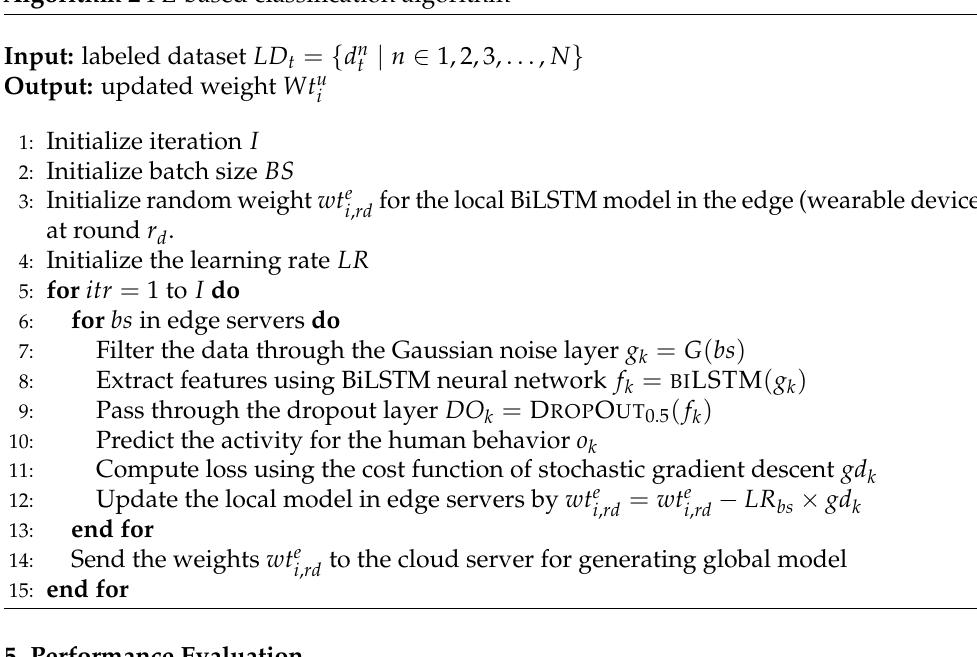
Algorithm 2 FL-based classification algorithm